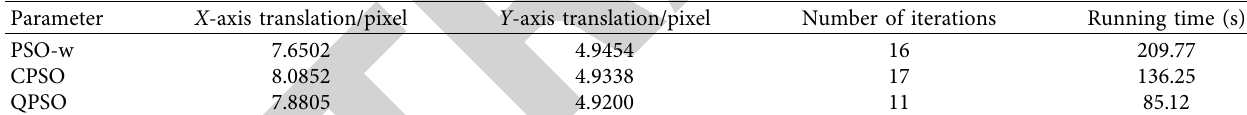
Figure 5: Experimental results of the optimization algorithm. Table 5: The image registration parameters based on gradient information.